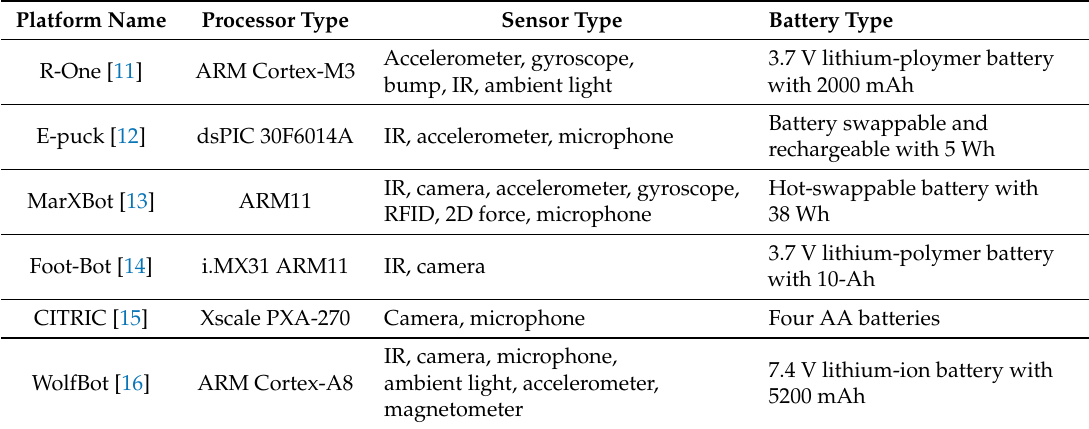
Table 1. Mobile sensing